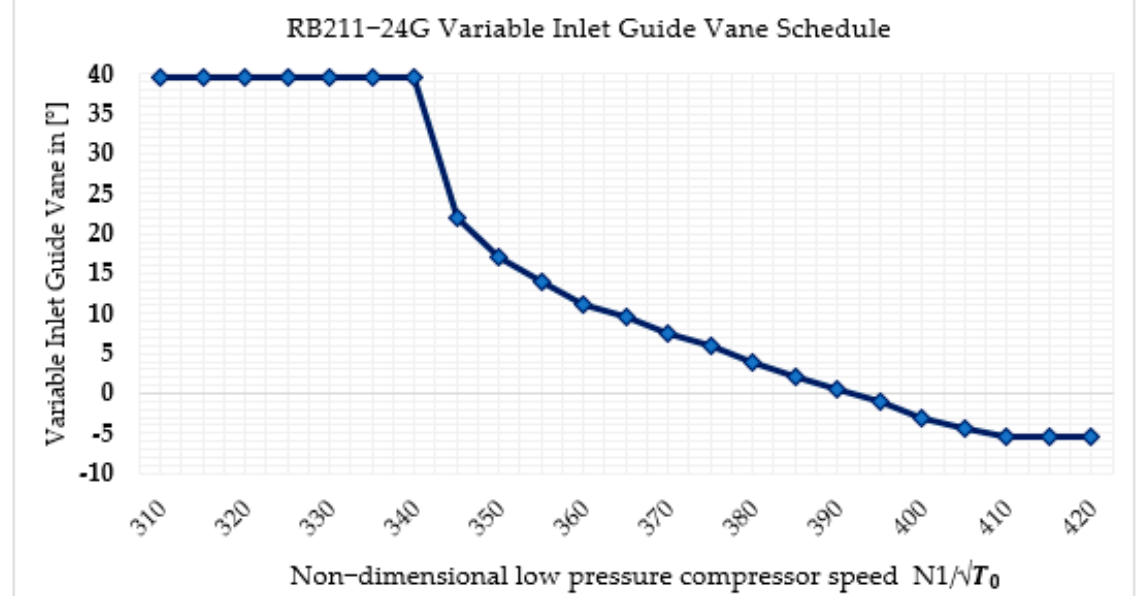
Figure 3. VIGV schedule.